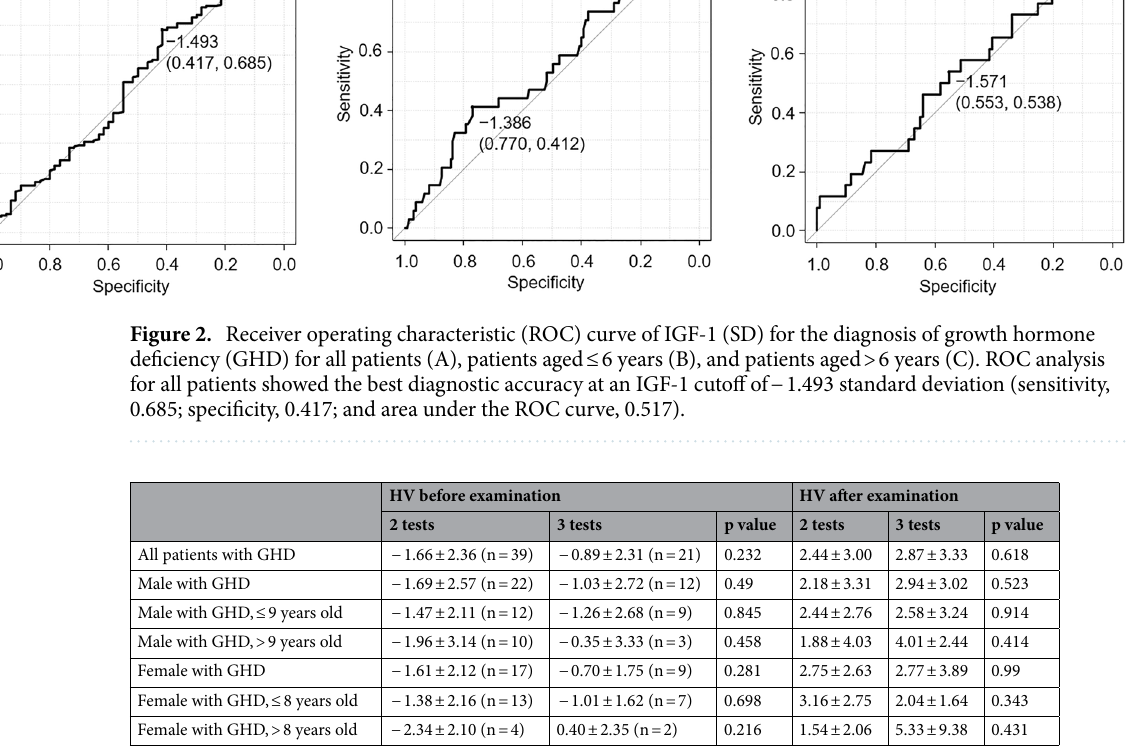
Table 2. Analysis of height velocity according to the age group before and after examination. HV, height velocity; GHD, growth hormone deficiency.